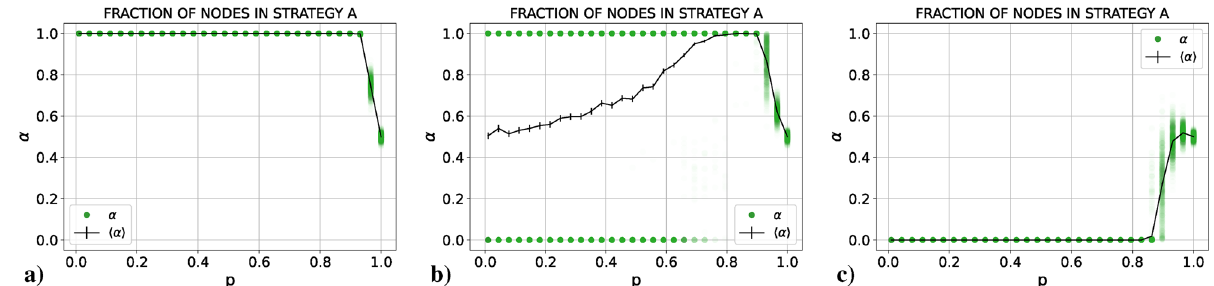
Figure 5. Results for α as a function of p for a GCG with coevolution played in an E–R network with � k � = 30 , using the RD update rule, whose parameters are ( a ) ( S , T ) = ( − 1.5, − 1.5 ) , ( b ) ( S , T ) = ( − 2, − 1 ) and ( c ) ( S , T ) = ( − 2.5, − 0.5 )